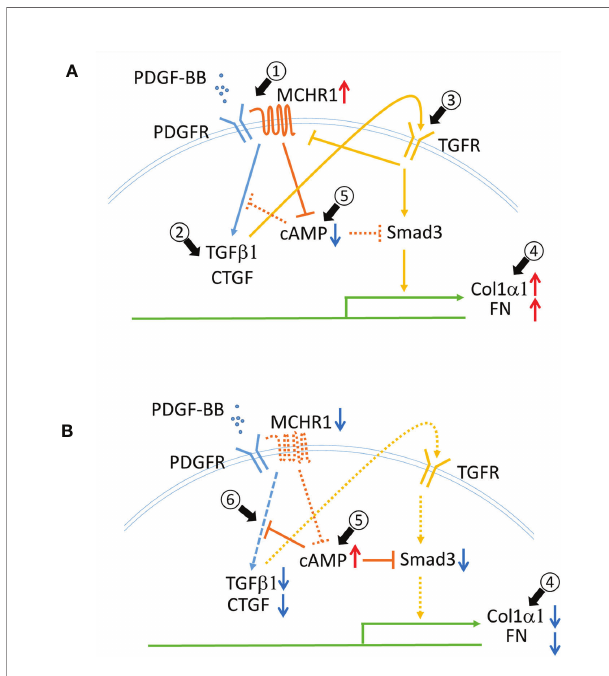
FIGURE 6 | Schematic representing the role of MCHR1 in the fi brotic response elicited by PDGF-BB in NHDF. (A) PDGF-BB induces MCHR1, TGF b 1 and CTGF (arrow #1,2). PDGF-BB induced TGF b 1 increases ECM deposition (arrow #3,4). MCHR1 reduces intracellular cAMP levels and enhances the cell response to TGF b 1 (arrow #5). (B) Without MCHR1 signaling, intracellular cAMP levels increase (arrow #5), and PDGF signaling is attenuated (arrow #6). Increased cAMP levels reduce PDGF-BB induced TGF b 1 and CTGF and prevent the cell response to TGF b 1 (arrow